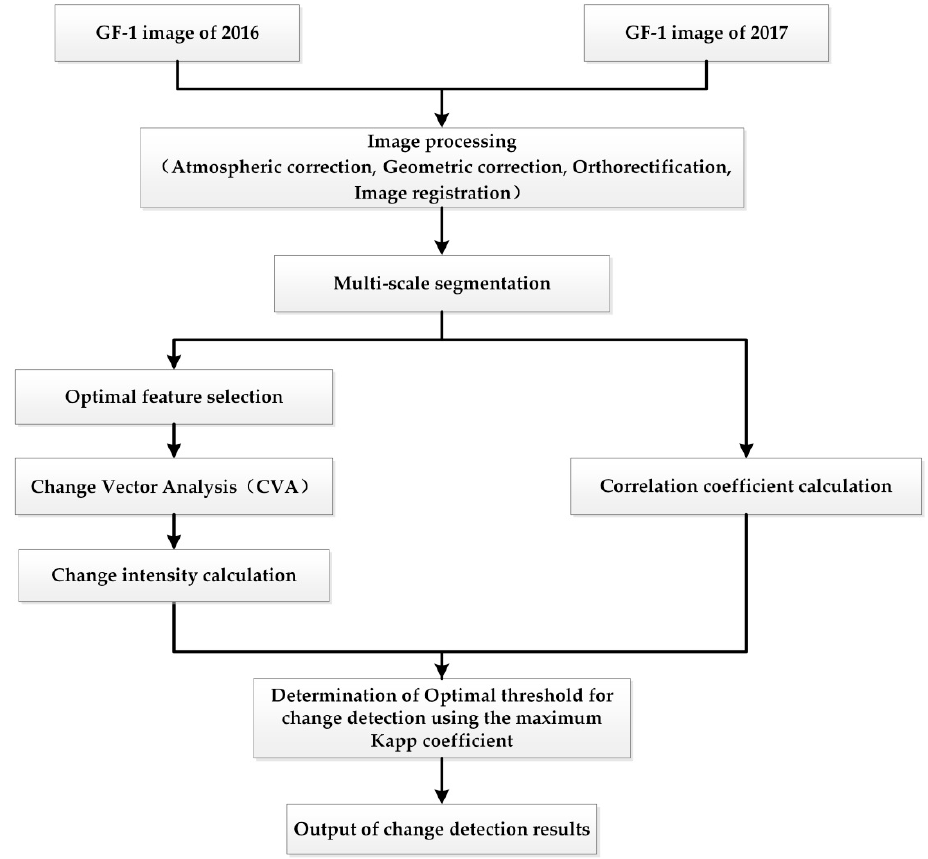
Figure 2. Flow chart of object-level double constrained change detection (ODCD).